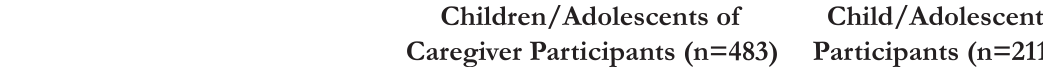
Table 2. Demographic and Clinical Characteristics of Child/Adolescent as Reported by Caregiver Children/Adolescents